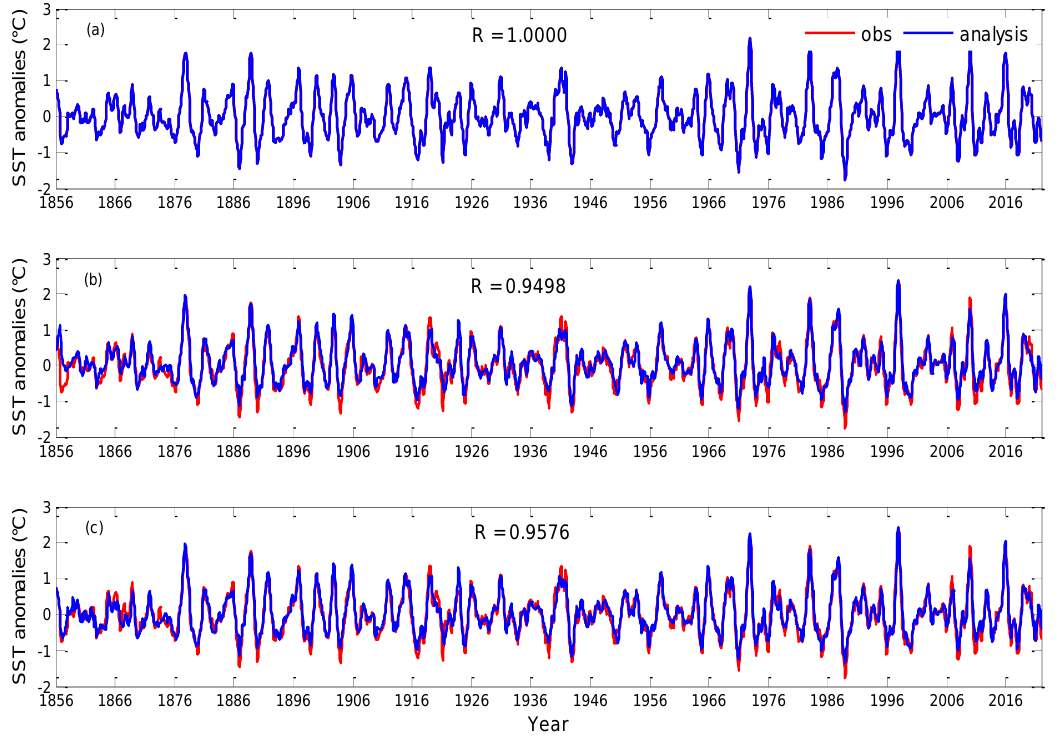
Figure 8. Time series of observed (red) and analyzed (blue) Niño3.4 SST anomalies: ( a ) Ori-Assim, ( b ) EAKF -Assim, and ( c ) EAKF_F-Assim schemes.